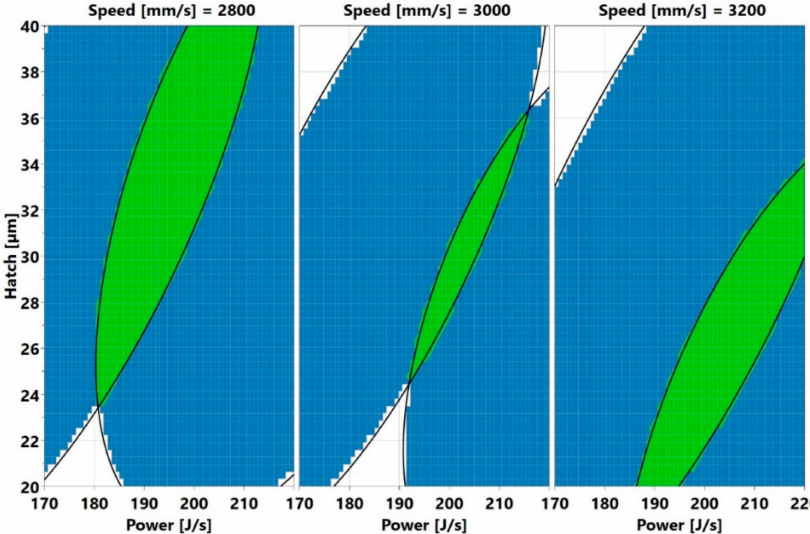
Figure 22. Hatch versus power and speed plots (the green areas represent process parameter sets. which yield low void content and low crack density, i.e., less than 0.05% and 0.05 / mm of void fraction and crack density,